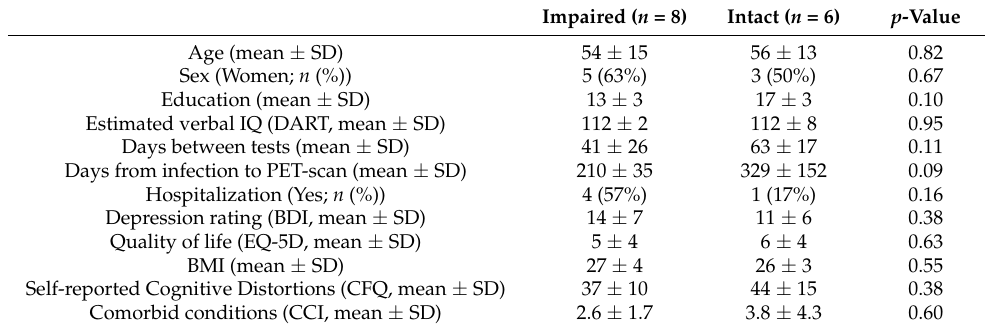
Table 1. Demographic and clinical characteristics of the cognitively impaired and intact.